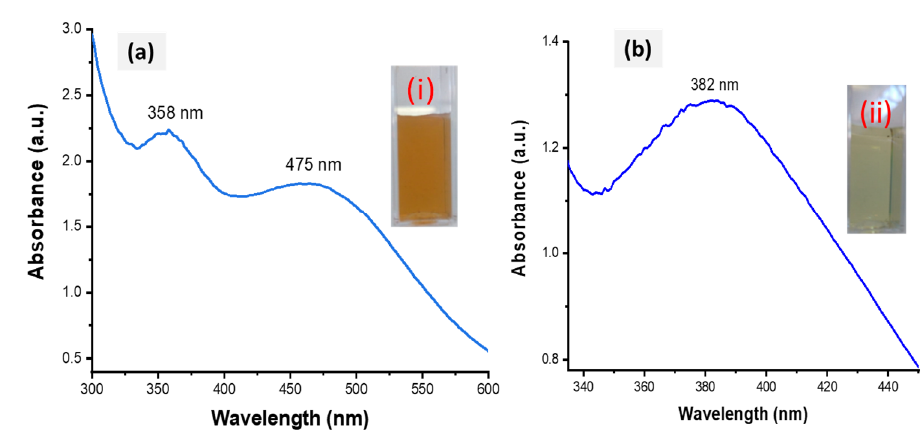
Figure 2. UV-Vis spectra of HE-AgNPs ( a ) and HP-AgNPs ( b ). The insets (i) and (ii) represent the colour of the HE-AgNPs and HP-AgNPs, respectively.